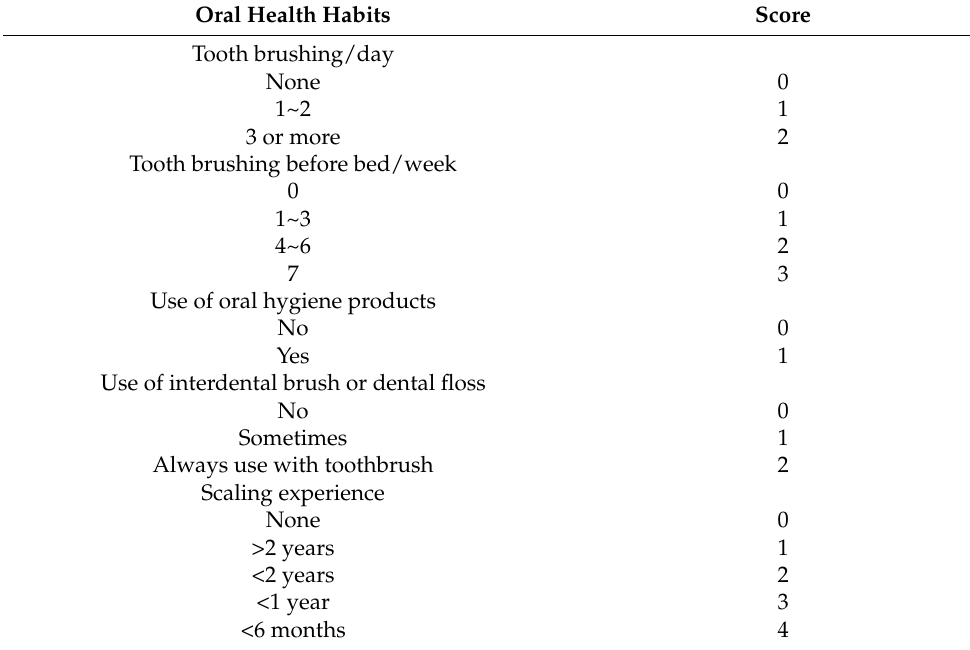
Table 1. Scoring to evaluate oral health habits in